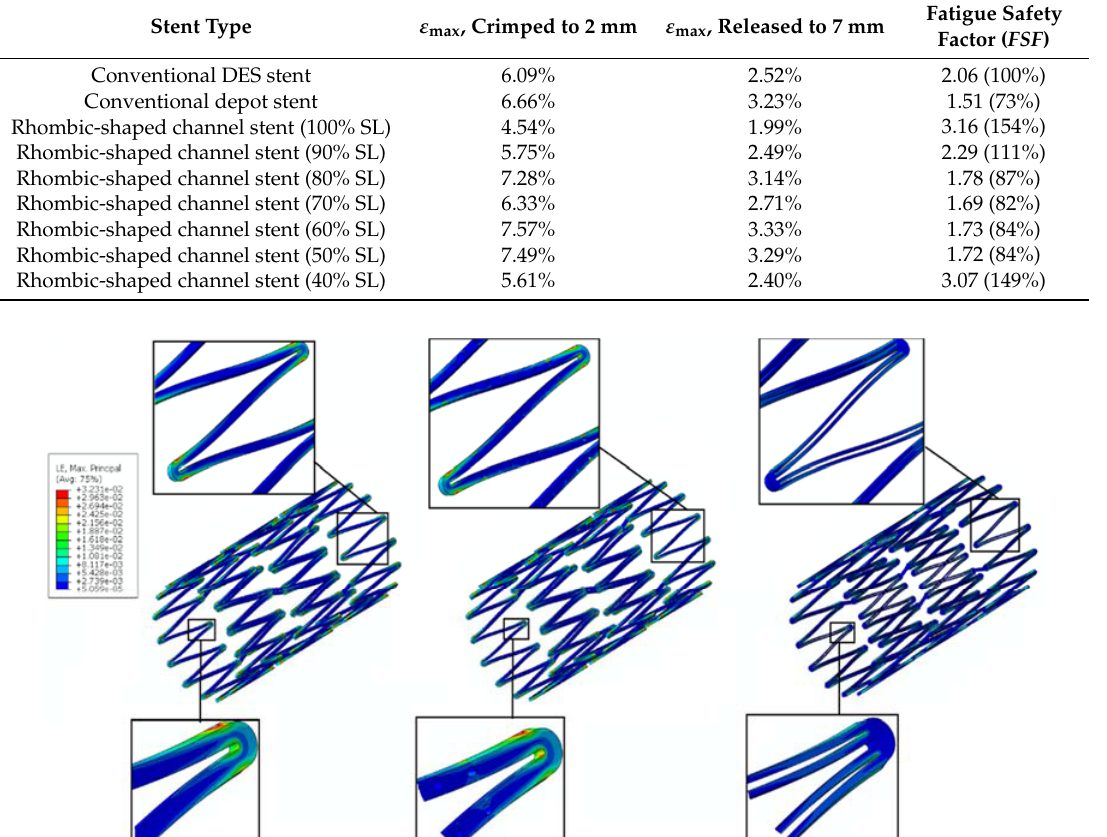
Figure 8. FEA contour plot comparison of strain distribution at 7.0 mm after release to a blood vessel among the conventional DES stent ( left ), conventional depot stent ( middle ), and rhombic-shaped channel stent ( right , reservoir length 100% of the strut length).